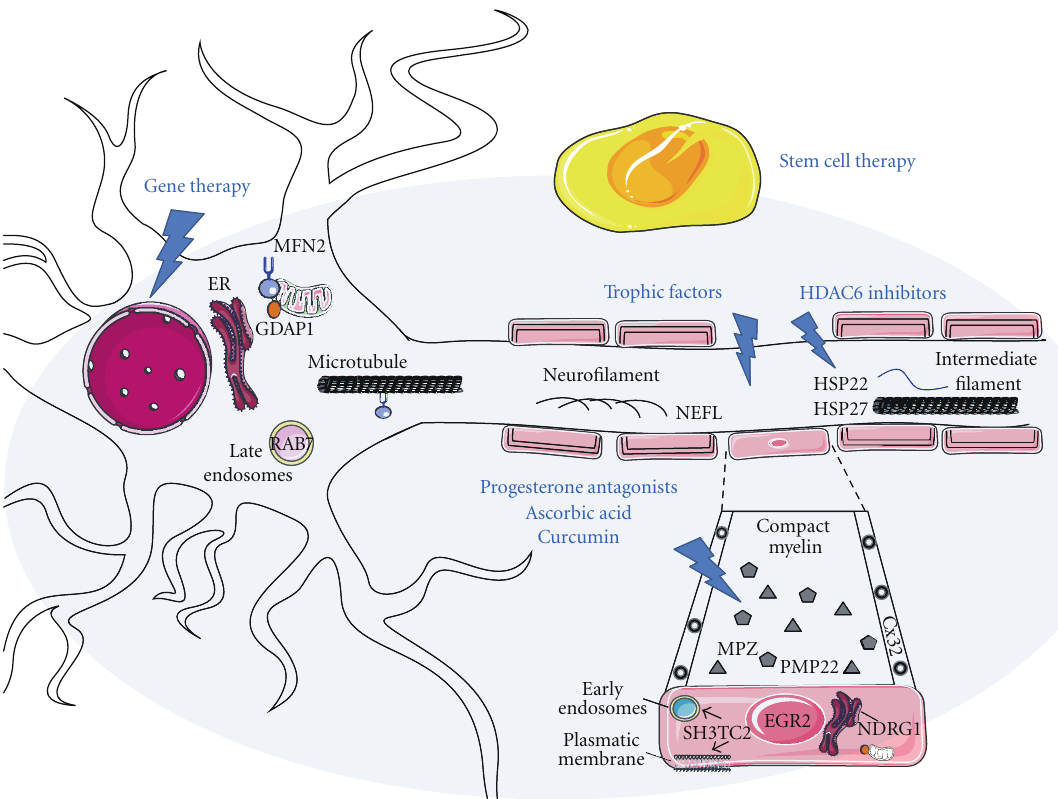
Figure 1: Peripheral nerve structure and cell localization of some CMT proteins at either the Schwann cell and myelin or the neuronal axon. (a) PMP22 and P0 are structural proteins located at the compact myelin and Cx32 at the noncompact myelin in the paranode (and also at the Schmidt-Lanterman incisures). Some other demyelinating CMT-associated molecules are SHT3TC2 at the plasmatic membrane and related to early endosomes and endosome recycling, the transcription factor ERG2 working in early promyelination programme, and NDRG1 that is ubiquitously expressed and has been proposed to play a role in growth arrest and cell di ff erentiation, possibly as a signaling protein shuttling between the cytoplasm and the nucleus. Proteins mainly related to axonal CMT are associated with neurofilaments (NEFL), late endosomes (RAB7), mitochondria, endoplasmic reticulum and microtubules (MFN2 and GDAP1), or intermediate filaments (HSP22 and HSP27). (b) A ray sign indicates the main location where drugs or advanced therapies are acting. Stem cell therapy is represented as an open shadow grasping the neuron soma and axon and the Schwann cell. Trophic factors may be delivered as a drug but also by means of gene vectors or as a part of the local function of therapeutic stem cells. This figure was produced using Servier Medical Art